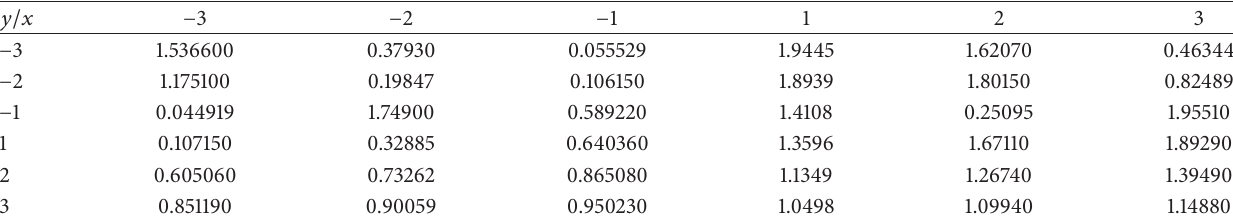
Table 4: Positive surface data from function 𝐹 2 (𝑥,𝑦) .